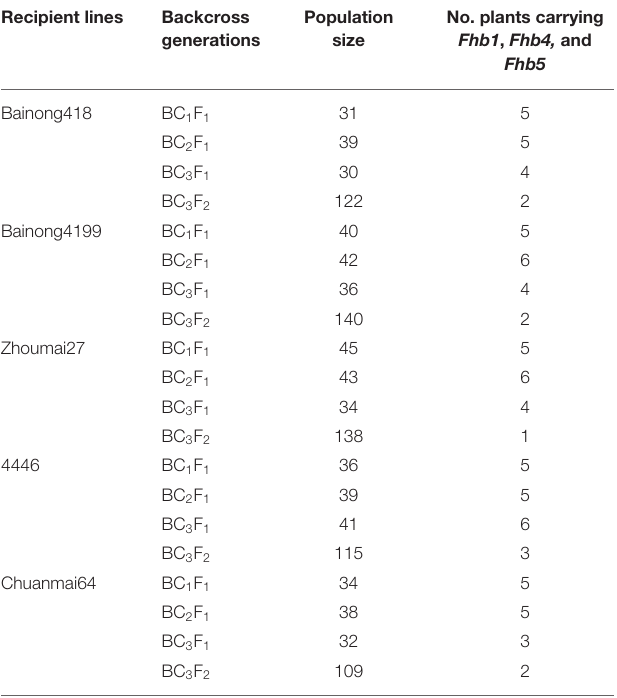
TABLE 1 | Population size and the number of plants carrying Wangshuibai (WSB) Fhb1 , Fhb4, and Fhb5 in the backcross and F 2 generations derived from each recipient